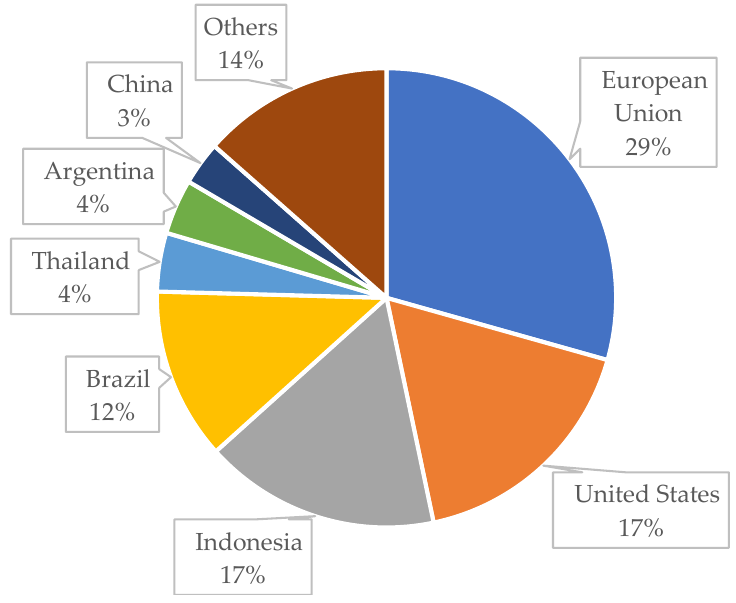
Figure 4. World biodiesel production, 2020. Source: authors ’ composition based on [11].